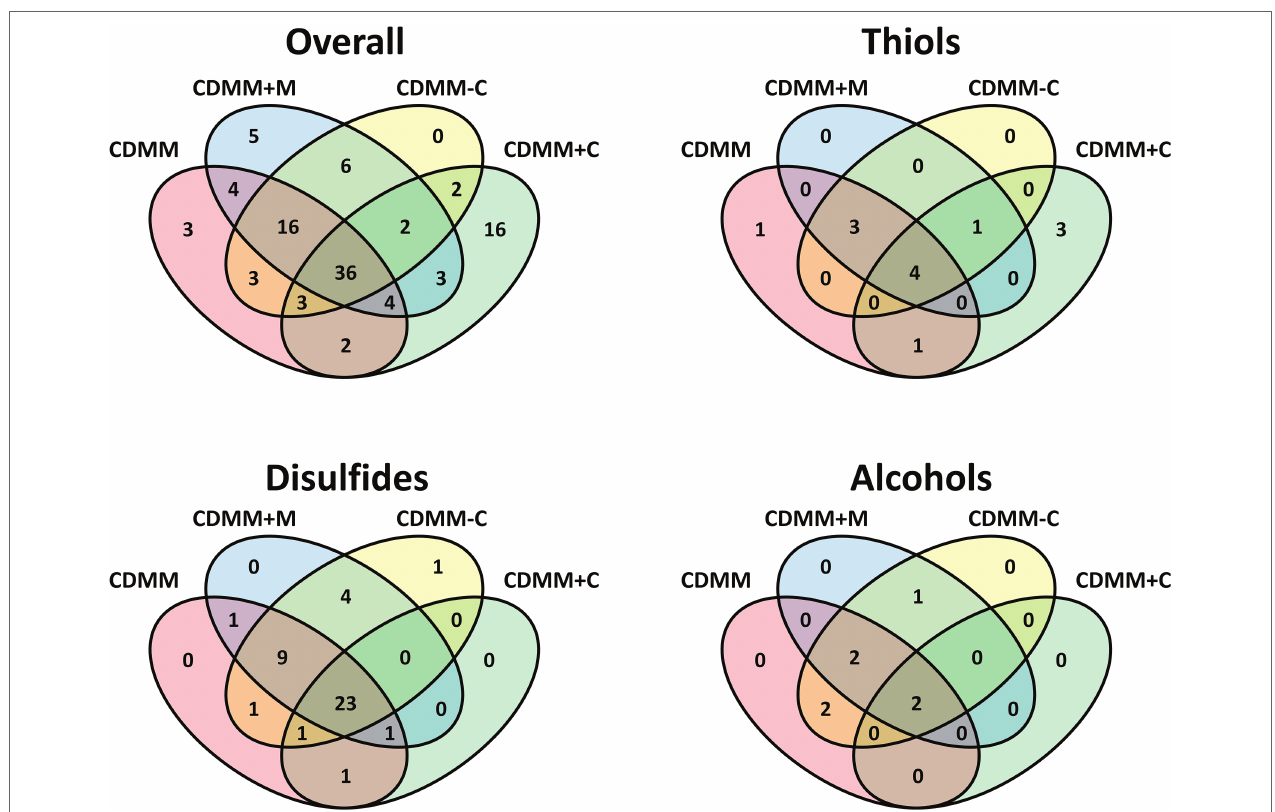
FIGURE 5 | Venn diagrams of volatile organic compounds from Clostridioides difficile 630 Δ erm cultivated in four CDMM derived media. Overall includes all compounds, the other diagrams the respective compound